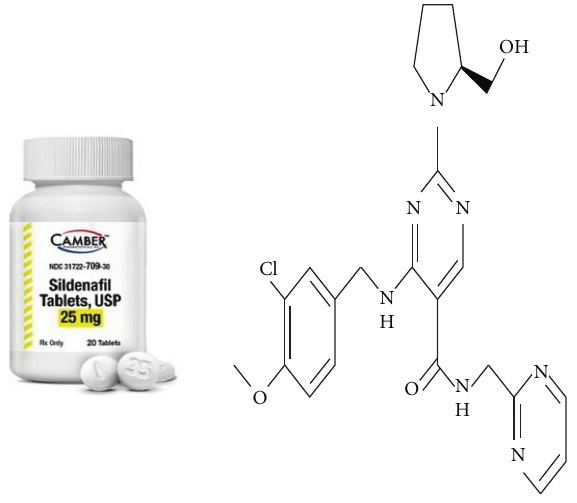
Figure 1: Graph structure of sildenafil. Table 1: Atoms dataset of the graph structure of sildenafil. No. of atoms